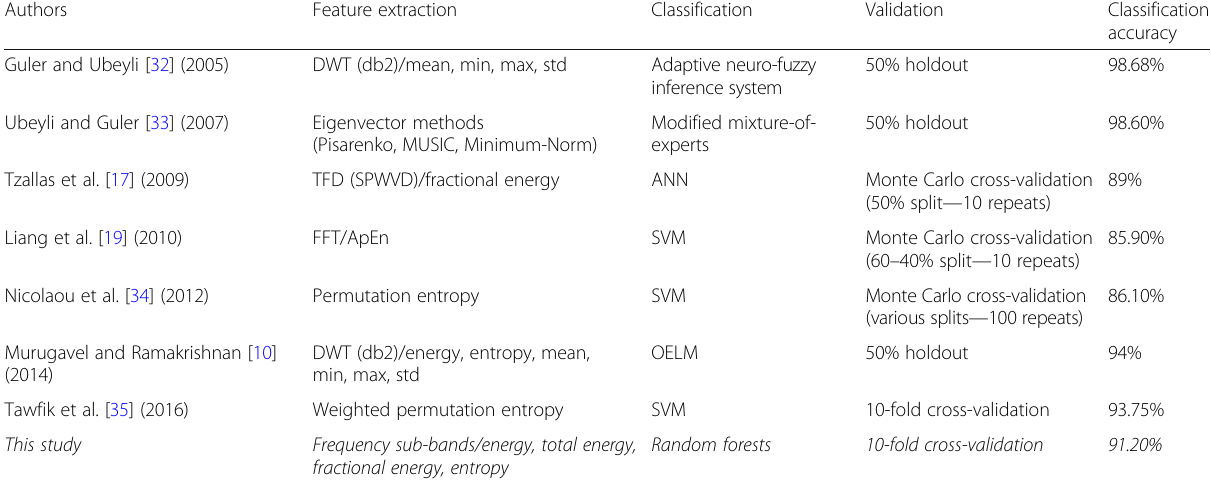
Table 7 Comparison of methodologies presented in the literature for the five-class (Z-O-N-F-S) problem Authors